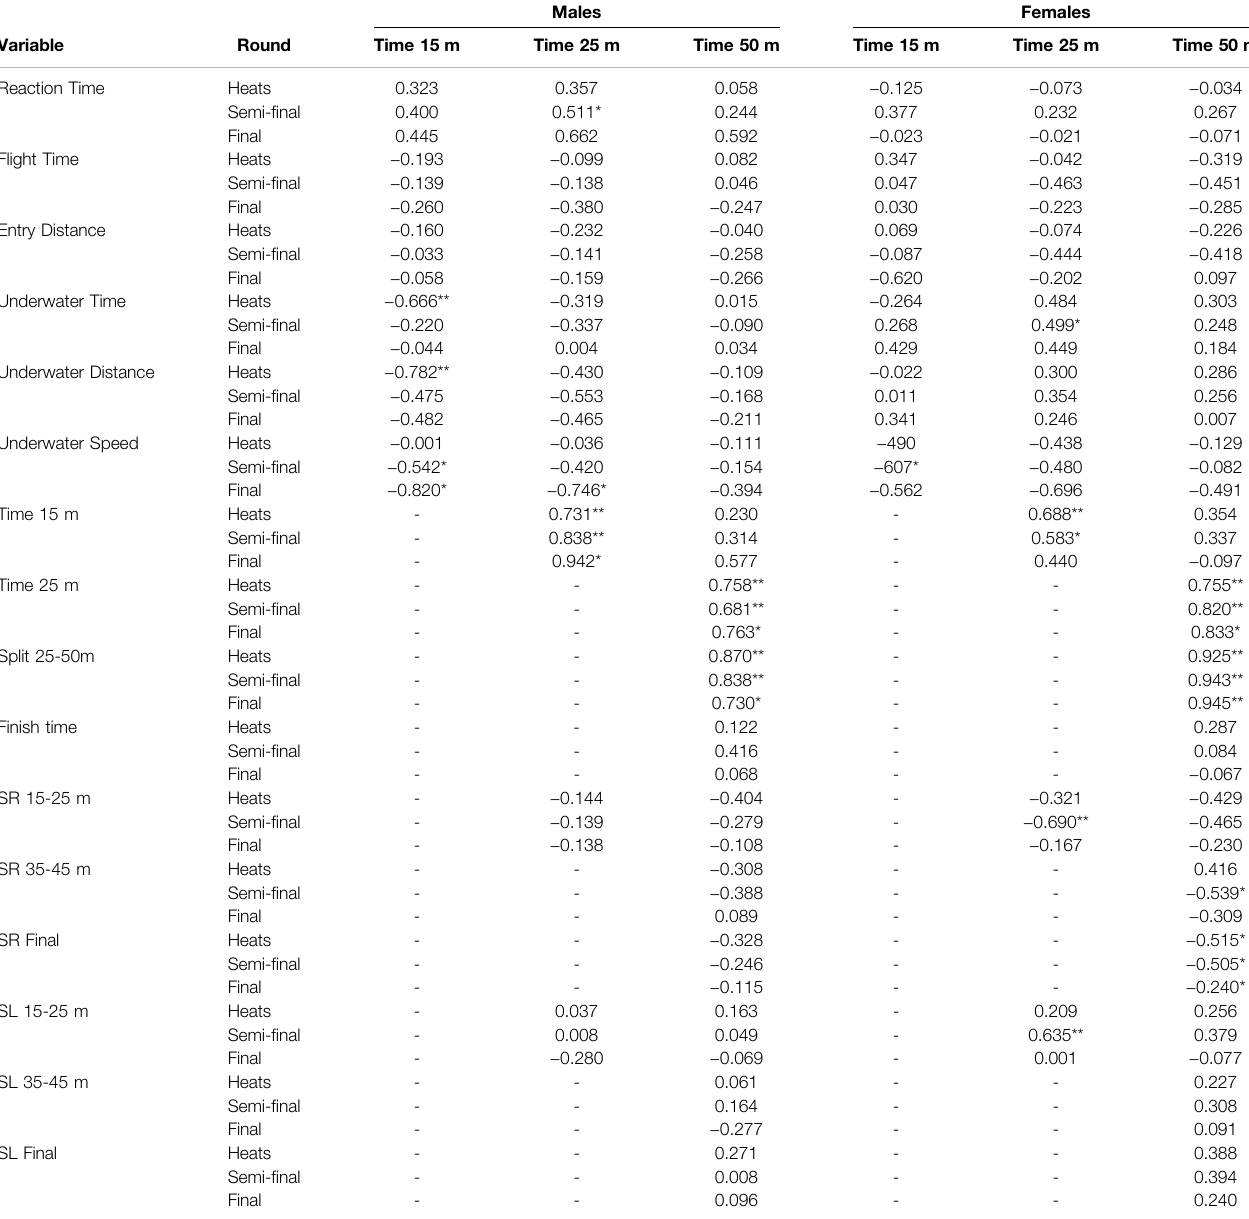
TABLE 11 | Pearson correlation coef fi cients (r) of the 50 m Breaststroke ’ s competition variables (LEN European Senior Championships 2021). Males Females Variable Round Time 15 m Time 25 m Time 50 m Reaction